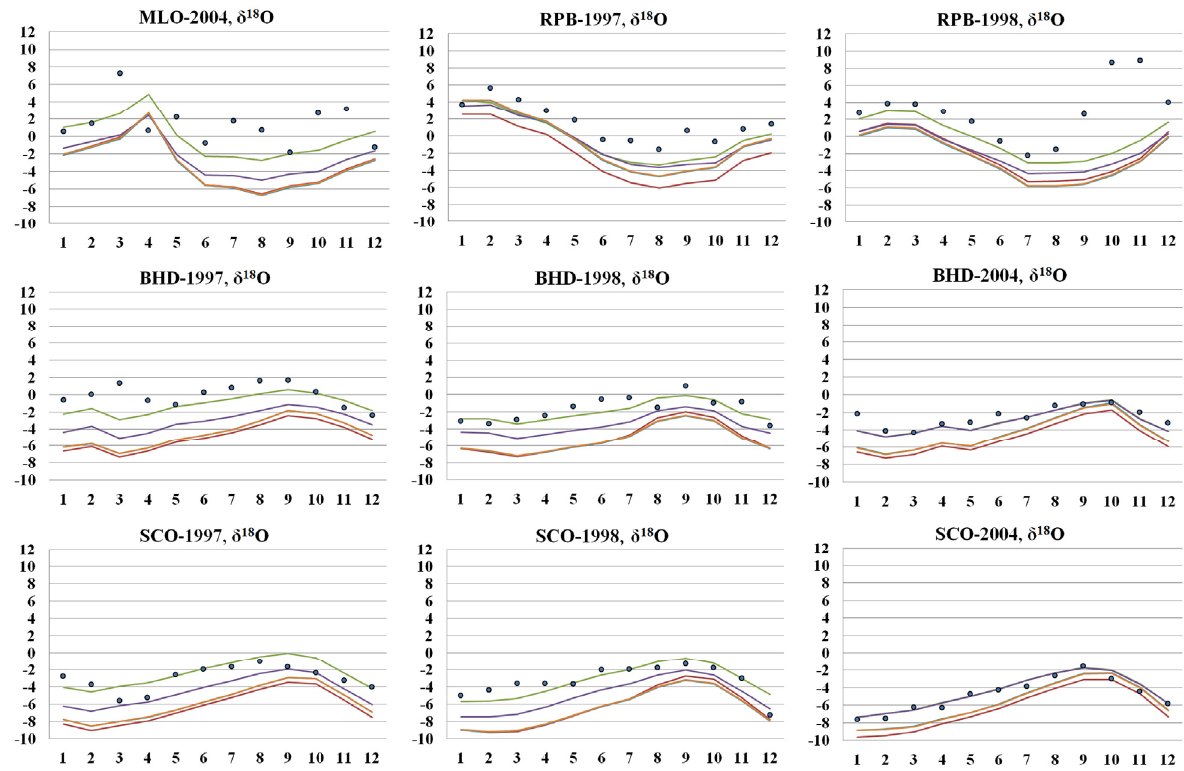
Figure 9. Comparison of a priori (brown line) and a posteriori modeled surface δ 18 O with measurements (blue dots). Green and purple lines denote a posteriori δ 18 O from simultaneous inversion and sequential inversion, respectively. Orange line is a posteriori δ 18 O with fixed isotope source signature. A posteriori isotope source signatures obtained from the simultaneous inversion are presented in the Table